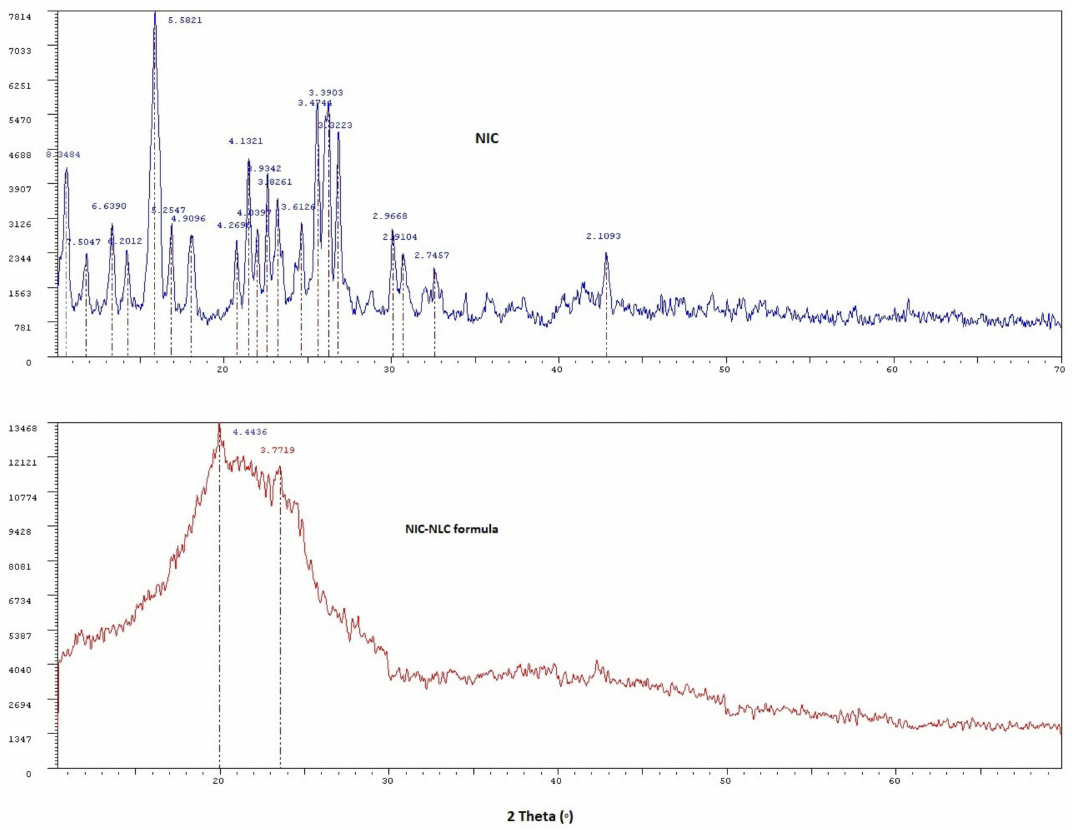
Figure 6. XRD diffractograms of NIC compared to the optimized NIC–NLC